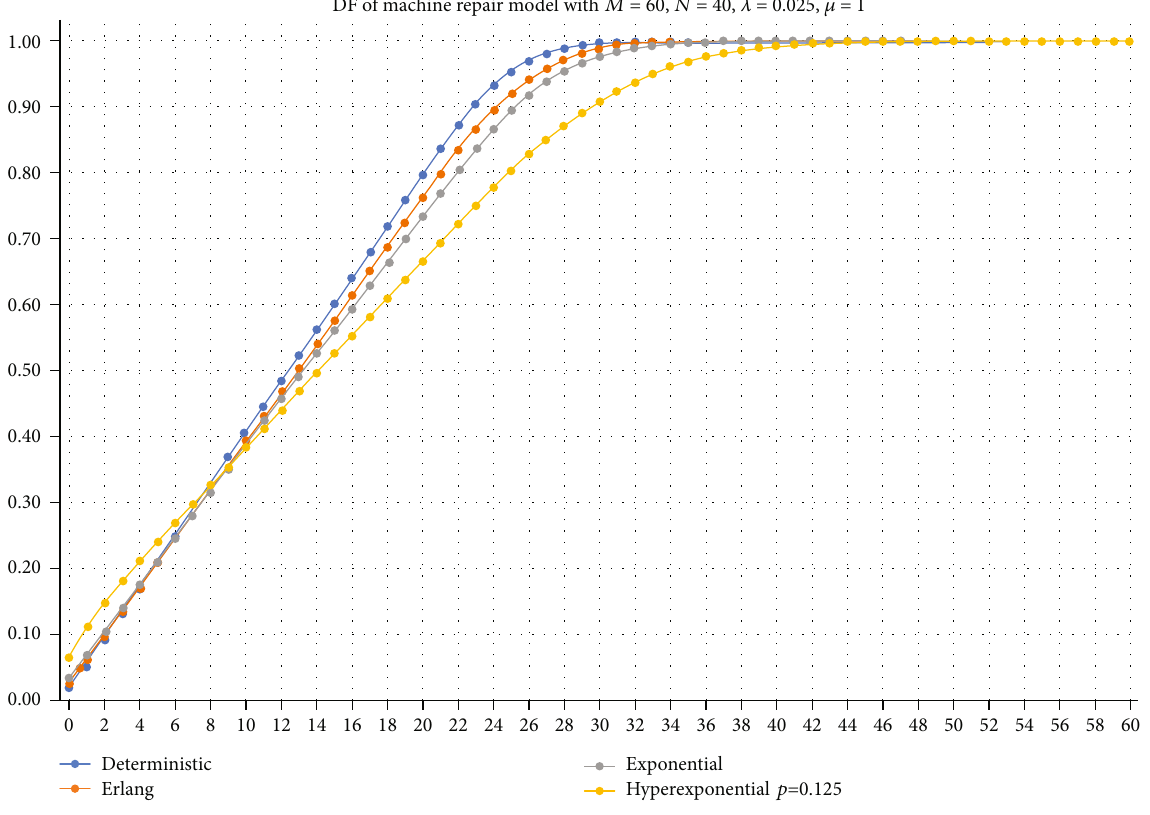
Figure 4: Cumulative distribution